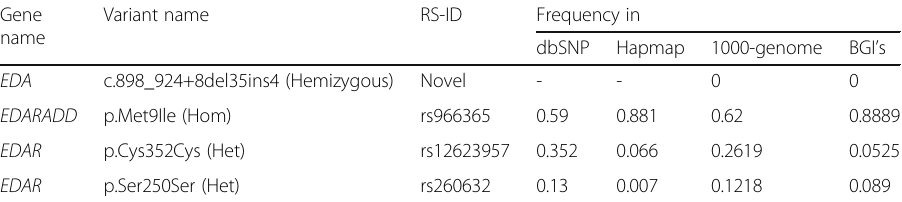
Table 1 List of the variants identified on EDA, EDAR and EDARADD genes in the affected child investigated by NGS